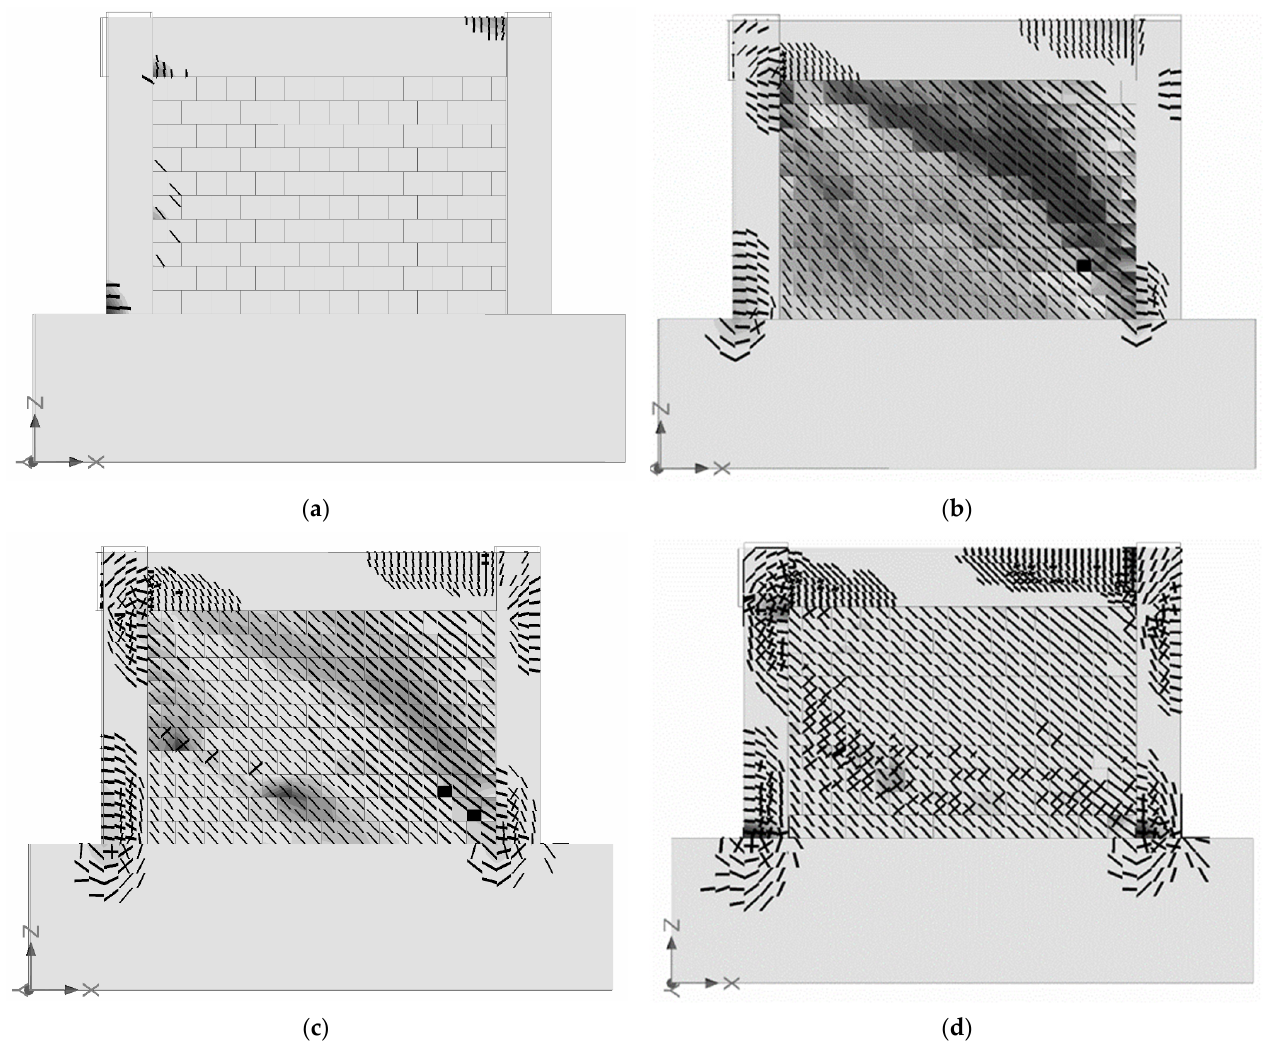
Figure 10. Proposed damage states of the infilled frame (failure mode and crack severity) based on meso model: ( a ) DS1; ( b ) DS2; ( c ) DS3; ( d ) DS4.